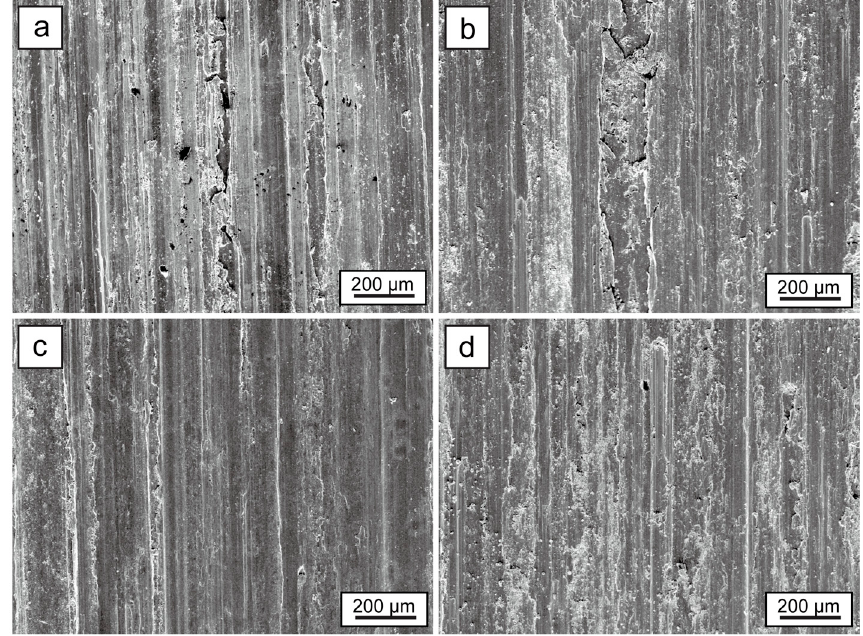
Figure 16. The SEM images of wear surface: ( a ) Ti6Al4V alloy; ( b ) TMCs modified with 0.2 wt % inoculant; ( c ) TMCs modified with 0.4 wt % inoculant; ( d ) TMCs modified with 0.6 wt % inoculant.